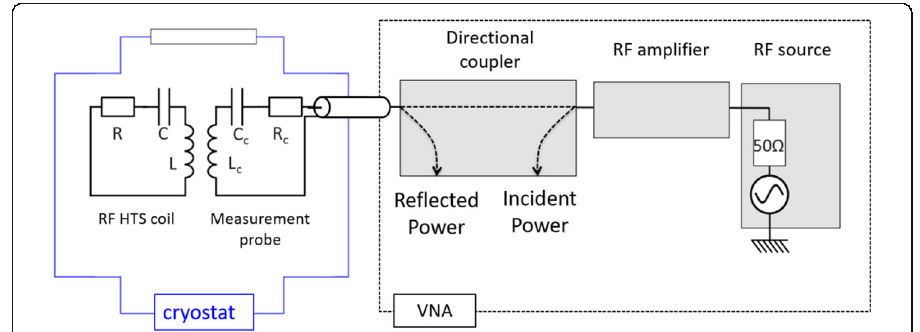
Fig. 2 Scheme of the RF measurement setup. The electrical parameters ( Q and f 0 ) of the HTS coil are inductively measured by